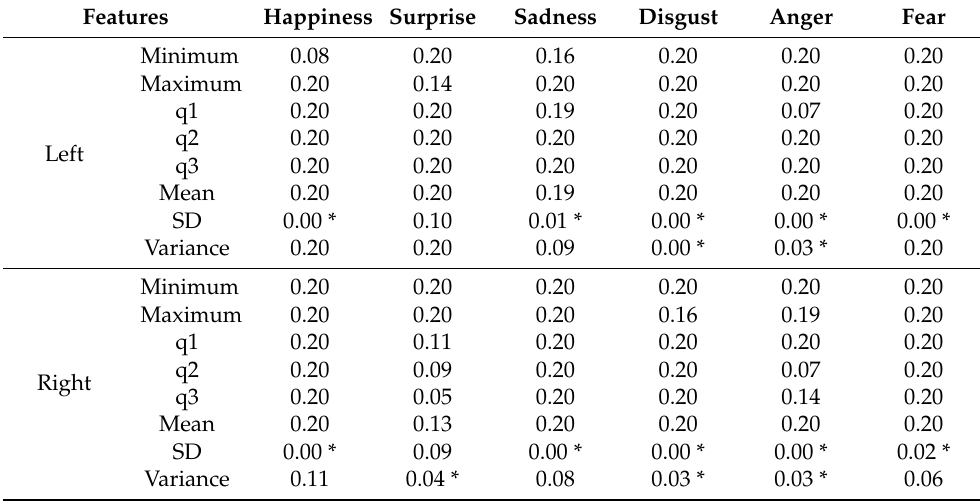
Table 1. Normality test for all features.